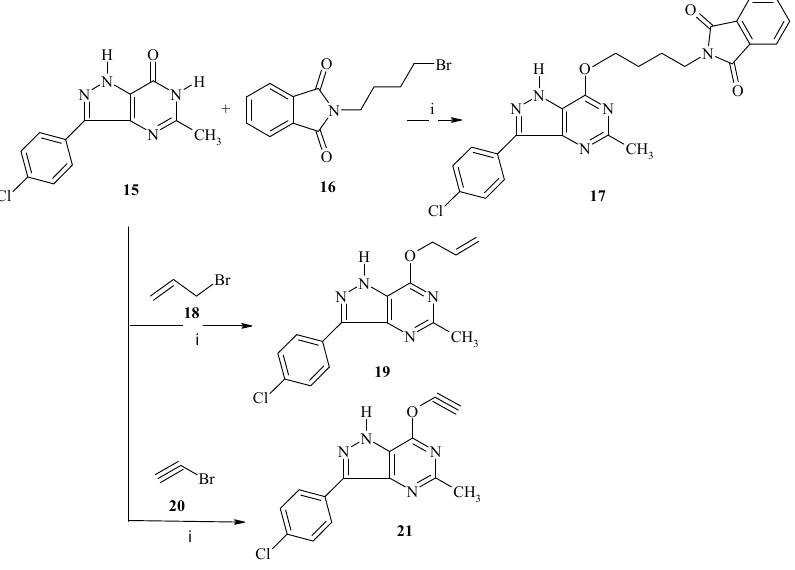
Scheme 4. Reaction of 3-(4-chlorophenyl)-5-methyl-1,6-dihydro-7 H -pyrazolo[4,3- d ]pyrimidin-7-one ( 15 ) with 2-(4-chlorobutyl)isoindoline-1,3-dione ( 16 ), allyl bromide ( 18 ) and bromoethyne ( 20 ); (i) K 2 CO 3 , DMF, 25 °C, 10